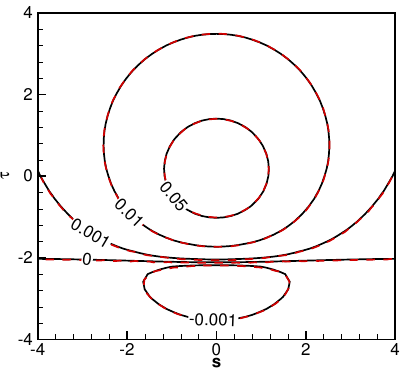
( s , τ ) , S = 2.0, T w / T = 1.5, α = 60 ◦ . Plate lengths 0 0 0 1 , d